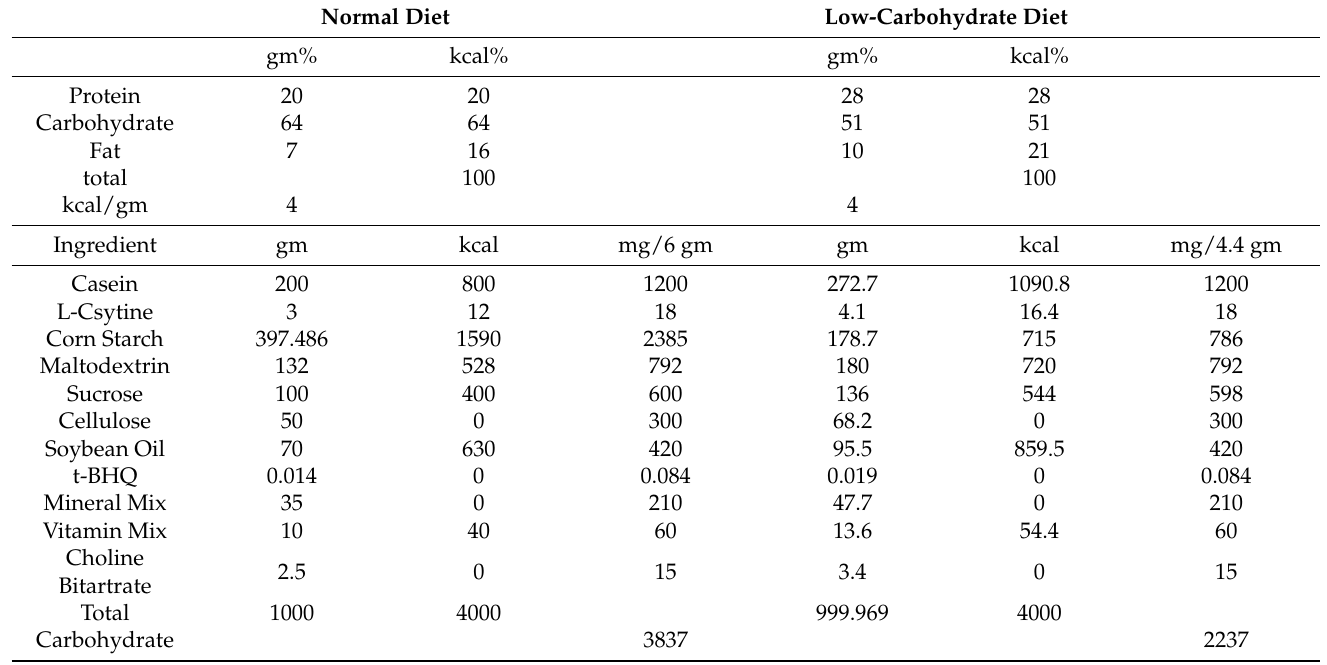
Table 1. Dietary composition for the normal diet and LCD. Abbreviation: gm,